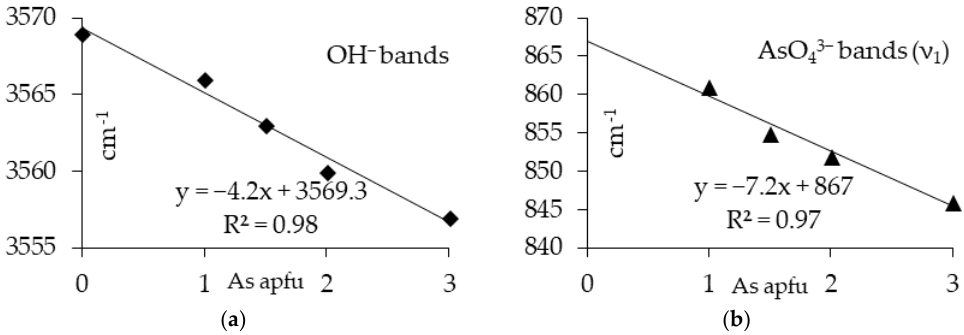
Figure 5. Systematic linear variations in the positions of the major Raman bands: ( a ) O–H vibrations and ( b ) symmetric stretching ν 1 As–O vibrations in the JBM–HAP solid solution series.